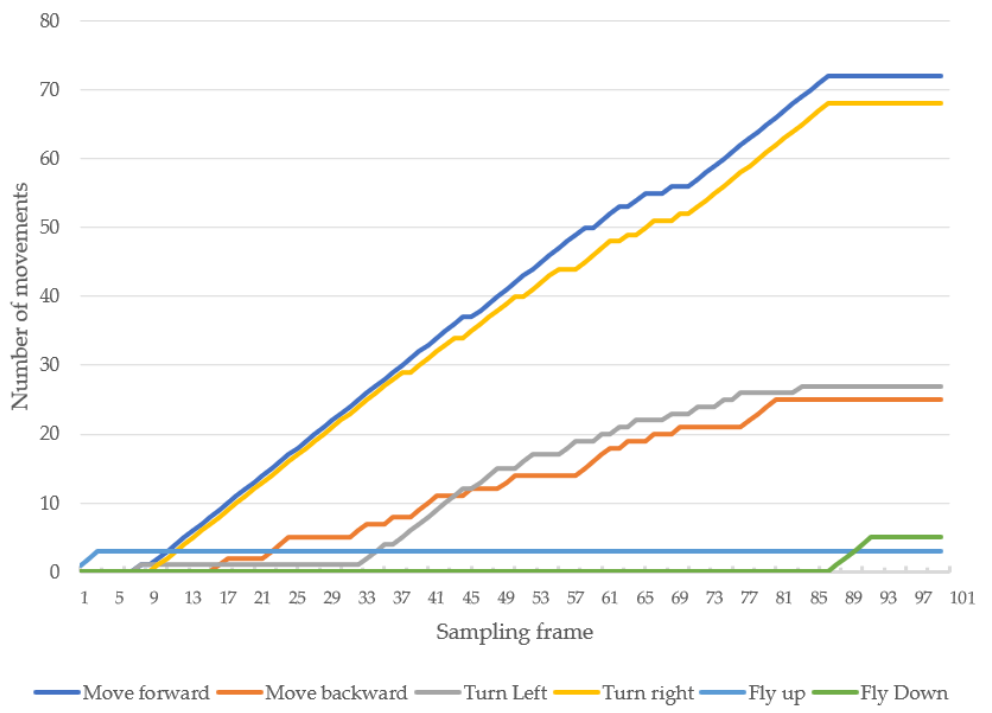
Figure 37. Accumulative movement numbers at various sampling frames.